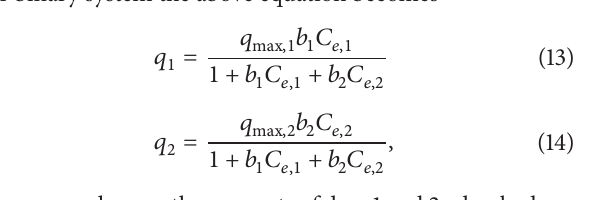
3.6.1. Extended Langmuir Equation (ELE). The